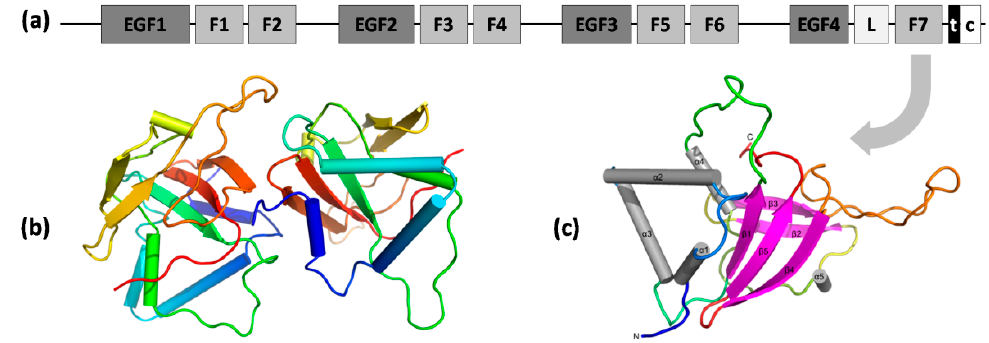
Figure 4. Domain organization of Stab1 and Stab2 receptors and the structure of FAS1 domain of Stab2. ( a ) Domains of stabilin receptors: EGF1–4—EGF ‐ like domain repeats (in four series); F1–7— ( a ) Domains of stabilin receptors: EGF1–4—EGF-like domain repeats (in four series); F1–7—seven FAS1 seven FAS1 domains; L—Link domain; t—transmembrane region; c—cytoplasmic (disordered) domains; L—Link domain; t—transmembrane region; c—cytoplasmic (disordered) domain; ( b ) domain; ( b ) structure of the seventh FAS1 domain of Stab2 (PDB ID 5N86)—cartoon representation